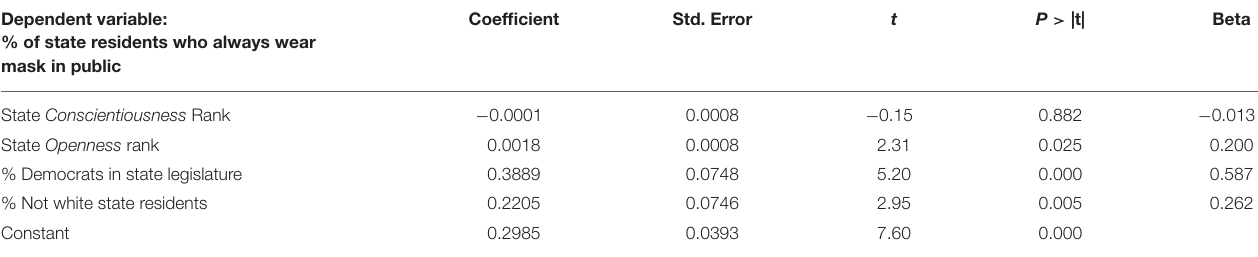
TABLE 3B | State Openness rank, partisan politics, and % of Non-White state residents predict % of state population who always wear masks in pubic. Dependent variable: % of state residents who always wear mask in